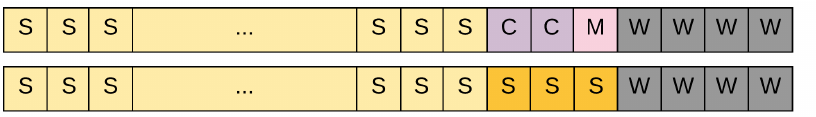
Figure 5. Results of initial classification (first row) and the Healing algorithm (second row) for the third special